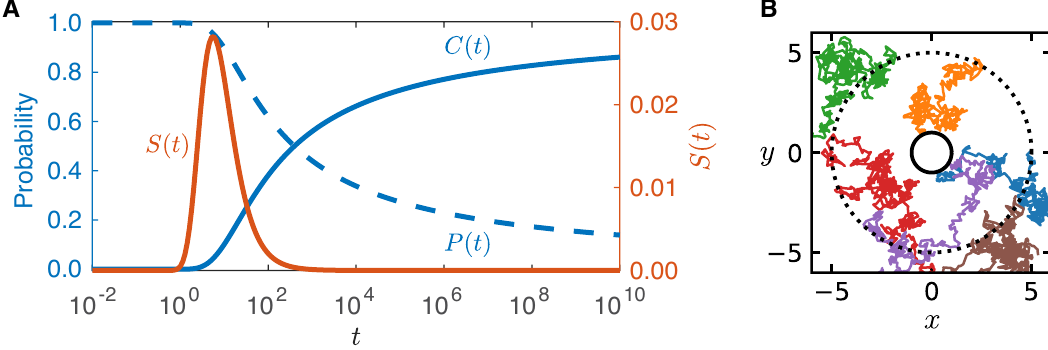
Figure 2. ( A ) Typical profiles for P ( t ) , C ( t ) = 1 − P ( t ) , and S ( t ) as derived from Equation(5), for D = 1 m/s 2 , r mate = 1 m, and r 0 = 5 m. The arrival time distribution S ( t ) is plotted on an axis with a smaller scale for clarity (red axis, right). ( B ) Example numerical simulation for 6 independent male moths (various colors; D = 1 m/s 2 ), with r mate = 1 m (solid circle) and r 0 = 5 m (dotted